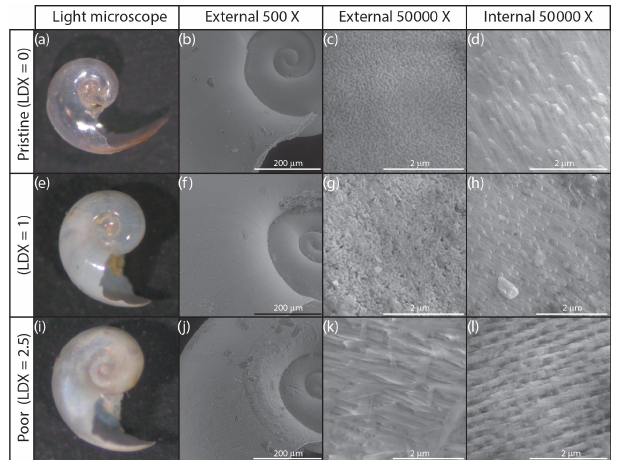
Figure 2. Light microscope (a, e, i) , and scanning electron micro- scope images of the external (b, c, f, g, j, k) and internal (d, h, l) walls of H. inflatus shells from the Cariaco Basin. Selected shells represent three examples of shell condition, ranked using the Li- macina Dissolution Index (LDX). Light microscope images show the shell changing from pristine and glassy (LDX = 0) to opaque and white (LDX = 2 . 5) with increasing dissolution. This change is accompanied by an increase in pocking on the external shell wall to reveal the edges of the prismatic crystals (c, g) and then the whole prismatic layer (k) . The topography on the internal shell wall is due to the terminations of the cross-lamellar crystals (d, h) . These be- come more distinct as dissolution increases the porosity of the in- ternal shell wall (l)